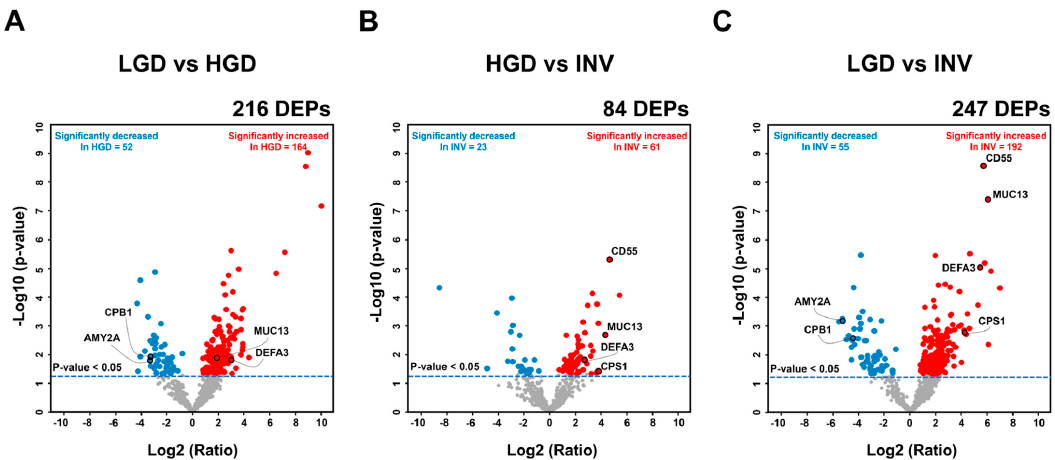
Figure 3. Volcano plots of differentially expressed proteins in three comparison groups. Student’s t-test ( p < 0.05) was conducted for comparisons 1 (low-grade dysplasia (LGD) versus high-grade dysplasia (HGD)) ( A ), 2 (HGD versus invasive IPMN) ( B ), and 3 (LGD versus invasive intraductal papillary mucinous neoplasm (IPMN)) ( C ) to discover differentially expressed proteins (DEPs). The DEPs that were significantly expressed in each comparison group are indicated as colored dots (red: upregulated DEPs, blue: downregulated DEPs). Several marker candidates, including the validation target CD55, are highlighted in each comparison. DEP, differentially expressed protein.